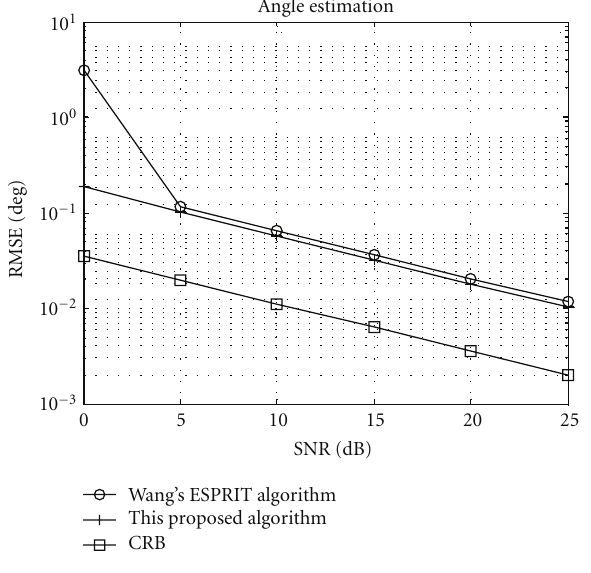
Figure 6: Angle estimation performance comparison at M = 16, K = 3, P = 3, and N = 400.